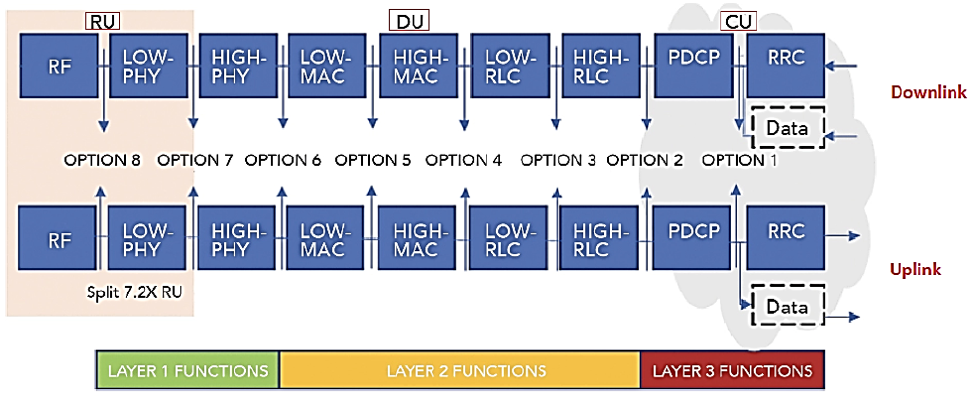
Figure 6. Eight functional split options with 5G xHaul network architecture for gNB-RU (Fronthaul) (RU->DU), gNB-DU (Midhaul) (DU->CU) and Backhaul (CU->core network). Based on [40].